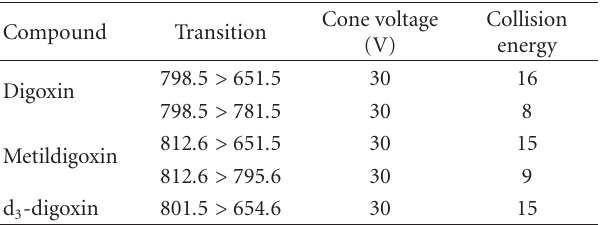
Table 1: MRM transitions, cone voltage and collision energy for digoxin, metildigoxin, and d 3 -digoxin (IS).